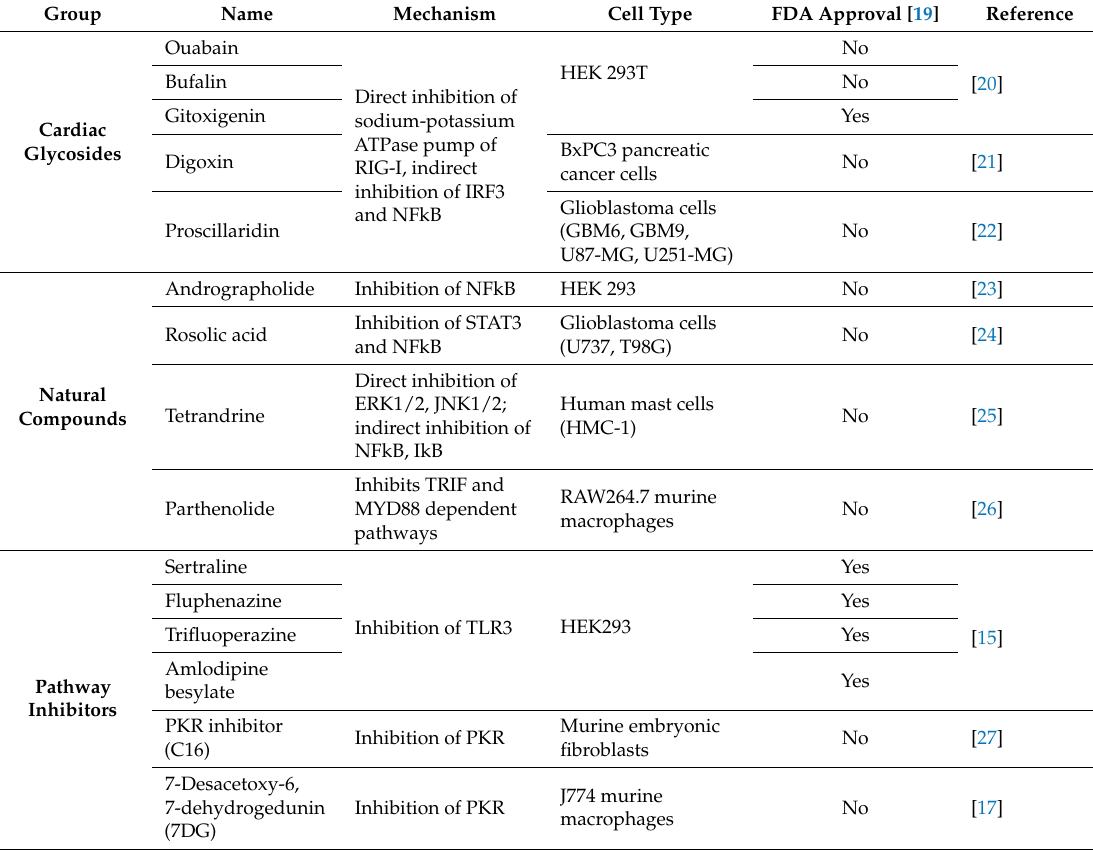
Table 1. Small molecule inhibitors and respective mechanisms of